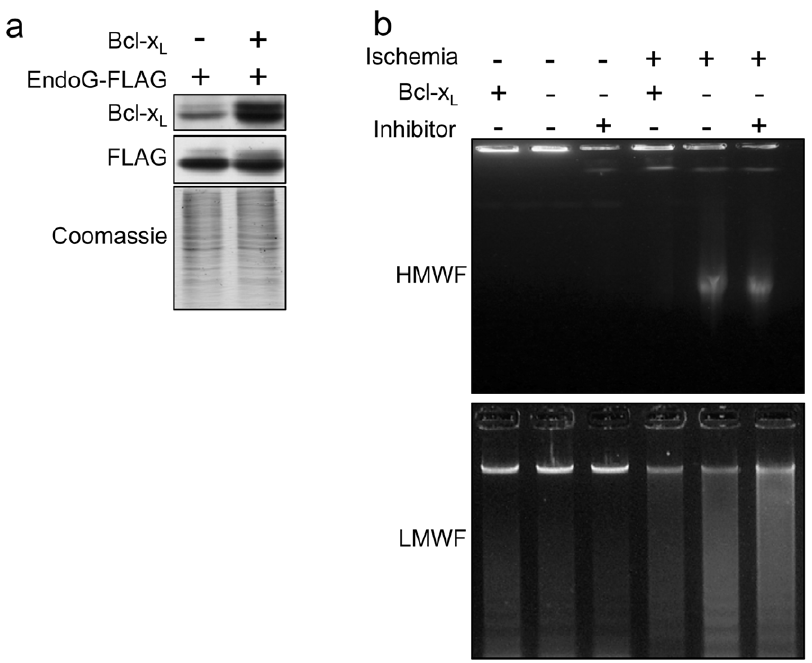
Figure 4. Bcl-x L can block caspase-independent DNA damage in ischemic cardiomyocytes. a) Assessing overexpression of Bcl-x L in normal cardiomyocytes and simultaneous EndoG-FLAG overexpression. b) Agarose gel electrophoresis of DNA extracts of cardiomyocytes cultured in normal conditions or after 6 hours of experimental ischemia. Cardiomyocytes were transduced 5 days before ischemia with lentivirus for overexpression of Bcl-x L or empty viruses. HMWF and LMWF: high and low molecular weight DNA fragmentation, respectively. Similar results were obtained in three independent